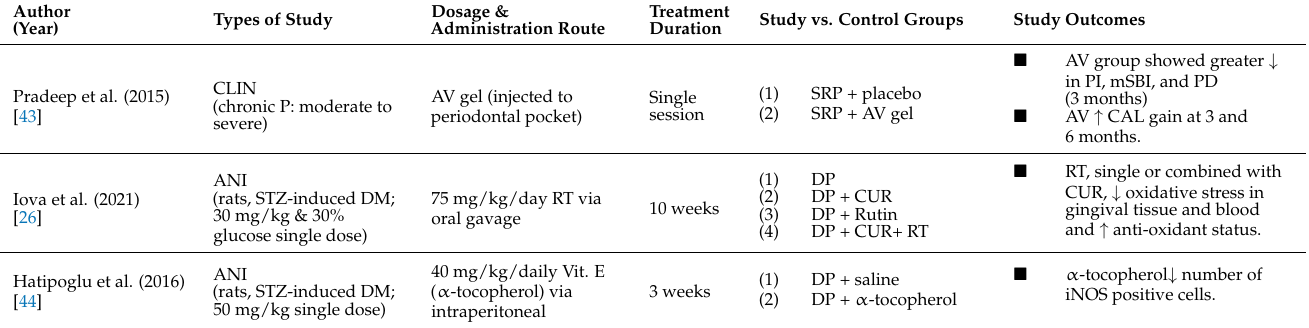
Table 9. Studies on the use of aloe vera (AV), rutin (RT), and vitamin E (Vit. E) in diabetes-associated periodontitis